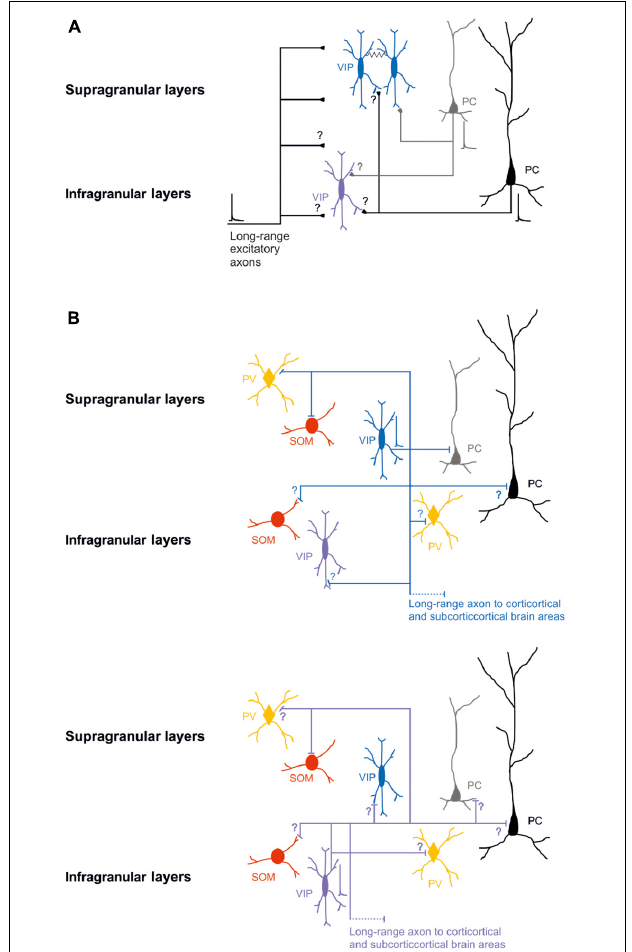
FIGURE 1 | Schematic wiring diagrams of neuronal circuits in the supragranular and infragranular cortical layers in which VIP-expressing neurons are involved. (A) Synaptic excitatory inputs from local and distal brain areas onto superficial and deep VIP-expressing neurons. (B) Synaptic outputs from supragranular VIP-expressing neurons (top) and infragranular VIP-expressing neurons (bottom) onto other types of neurons. Note that most of the connectivity between the different classes of neurons is still not known. VIP-expressing neurons are also electrically connected black line. Blue, VIP supragranular layer and purple VIP infragranular layer; Red SOM; orange PV; and gray superficial excitatory neurons and black deep excitatory neurons. Thick lines represent the axons that carries information and thin lines represent axons that are not active. Schematic action potentials are present depending on which neuronal circuit motive is